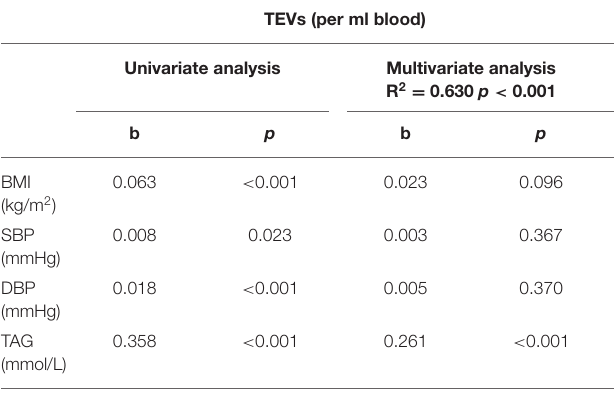
TABLE 2 | Associations between TEV numbers and conventional risk markers. TEVs (per ml blood)